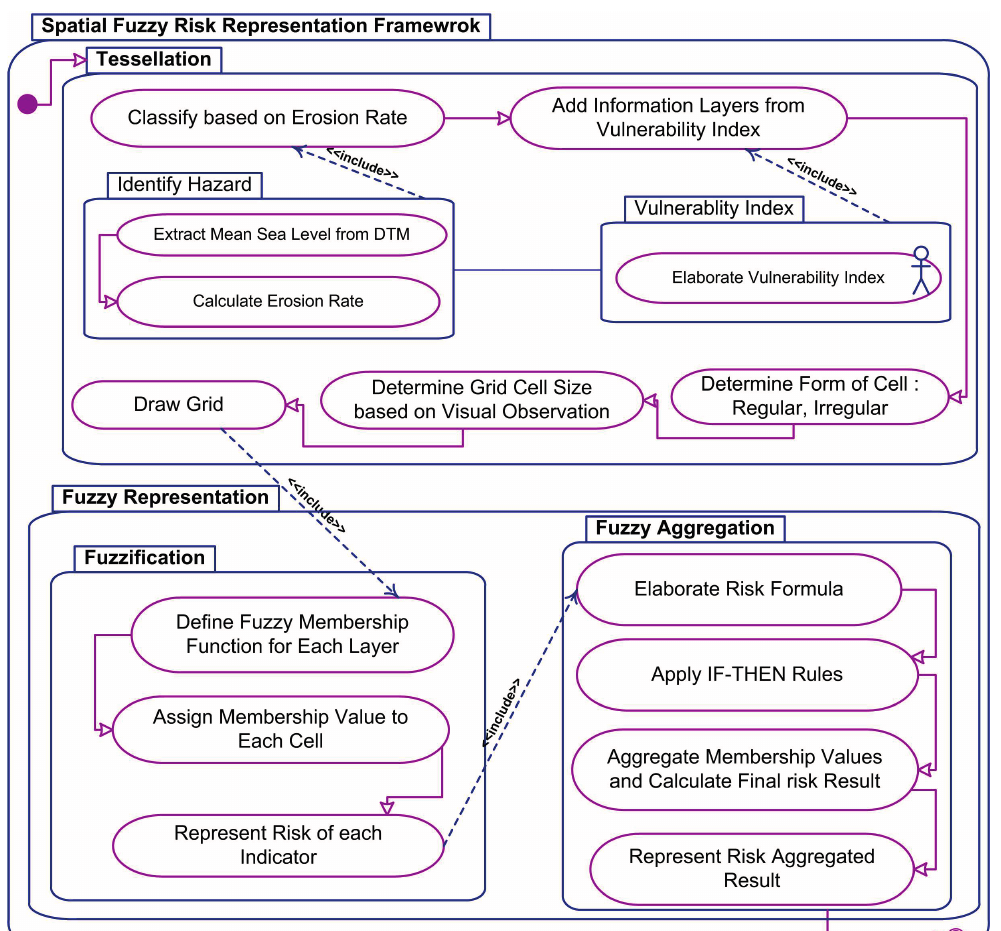
Figure 3. UML activity diagram of conceptual framework for spatial fuzzy representation of coastal risk